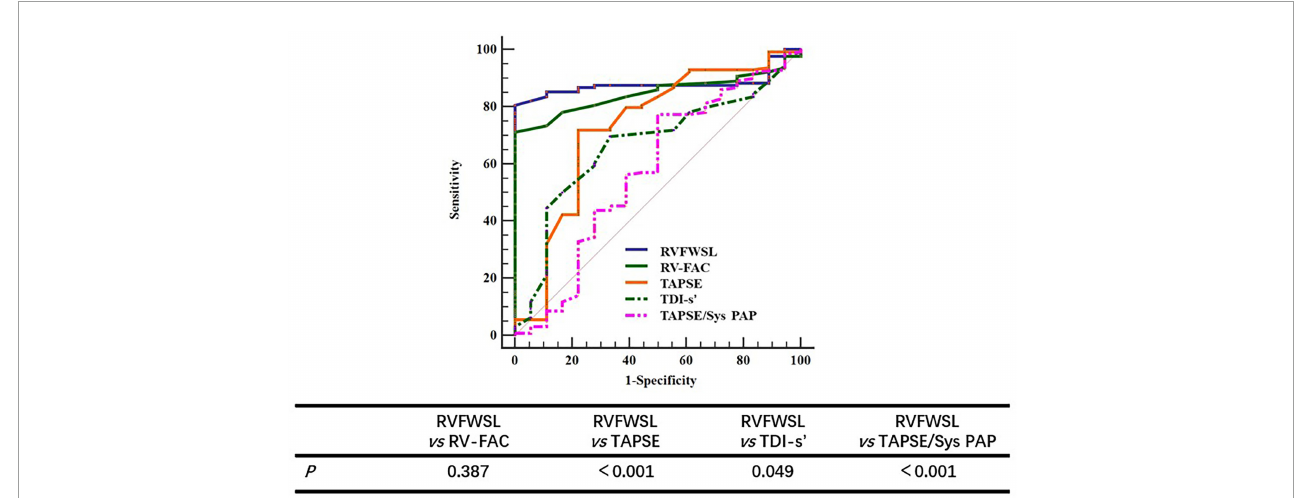
FIGURE3 The ROC curve of RV parameters for predicting LCOS. Comparing the value of different parameters in predicting LCOS, the results showed that there was no significant difference between RVFWSL and RV-FAC in predicting LCOS, but there was significant difference between RV RVFWSL and other parameters ( P <